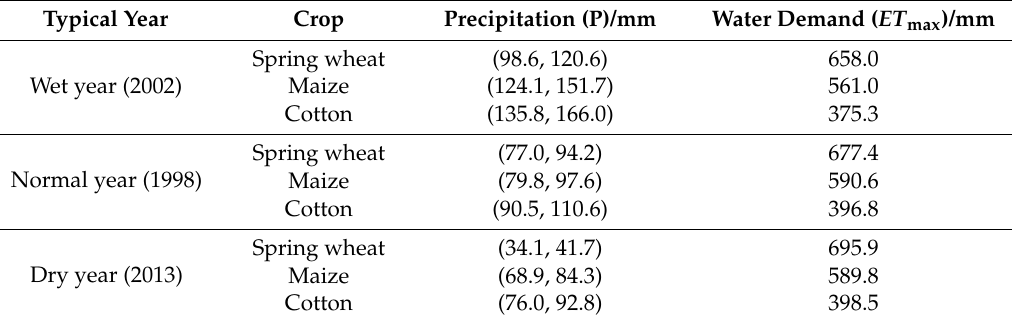
Table 1. The whole growth stage water demand of different crops and precipitation statistics of Minqin Oasis under typical years.